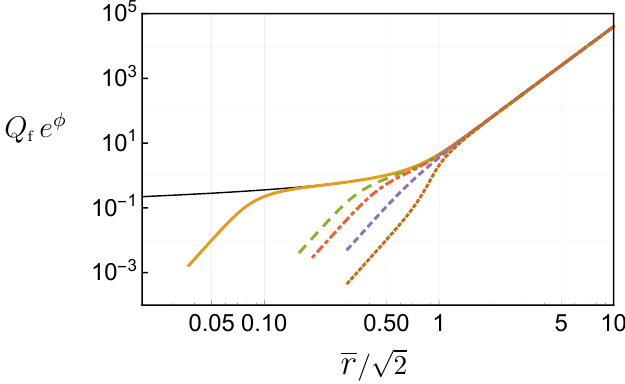
Figure 5. Radial pro(cid:12)le of the dilaton for solutions with the smallest value of r end) for di(cid:11)erent values of